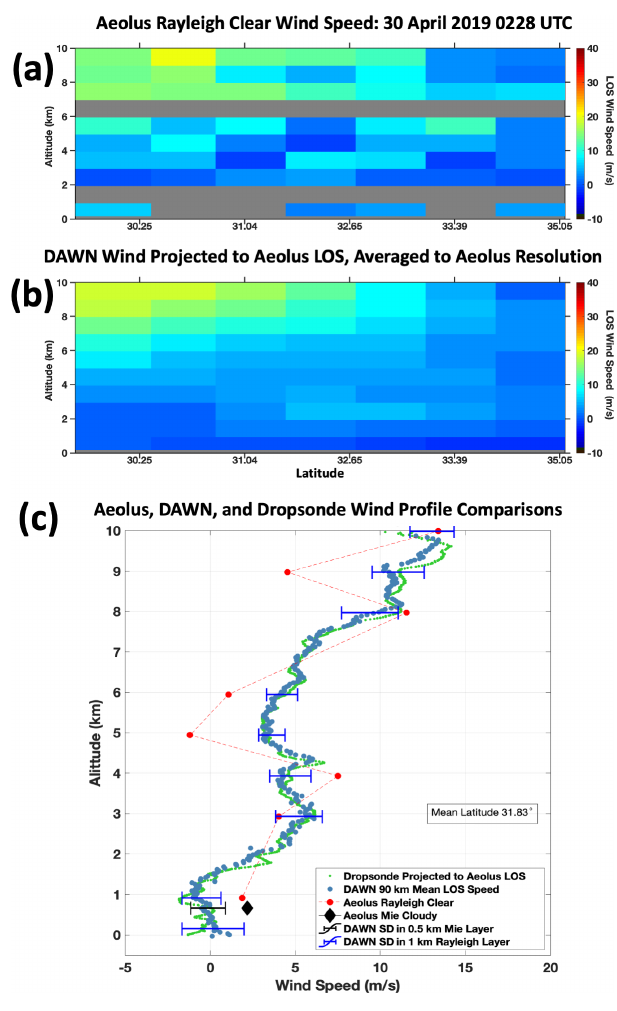
Figure 16. (a) Aeolus Rayleigh clear and (b) DAWN HLOS wind speed profile cross section, coinciding with the 0228UTC Ae- olus overpass on 30 April 2019. (c) The mean DAWN HLOS speed aggregated across the 90km Rayleigh clear integration dis- tance (blue), dropsonde-projected LOS speed (green), and Aeolus Rayleigh clear (red) and Mie cloudy (black diamond) speed. DAWN variance across the Rayleigh vertical bin depth and ∼ 90km hori- zontal distance are also overlain with blue